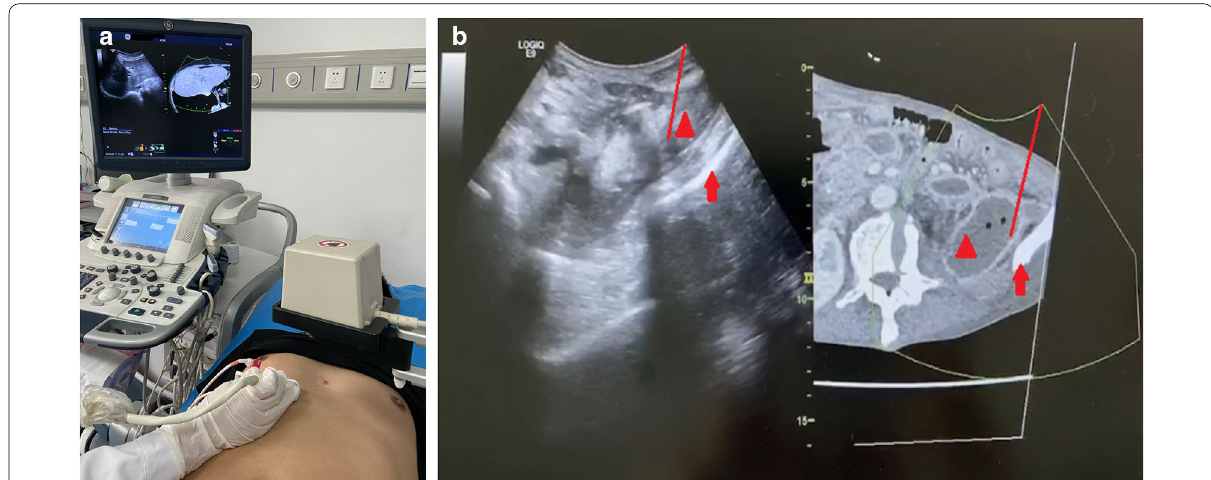
Fig. 2 Selection of the puncture pathway under the guidance of an ultrasonography (US)/computer tomography (CT) imaging fusion system. a The US/CT imaging fusion system consists of a magnetic sensor‑loaded ultrasonic detector, magnetic generator, and magnetic receiver, and the images of the liver are used for initial calibration. b The integrated image is displayed on the screen, puncture pathway (left midaxillary line) is indicated by red lines, walled‑off necrosis (retroperitoneal area behind the colon) is indicated by red triangles, and the left ilium is indicated by red